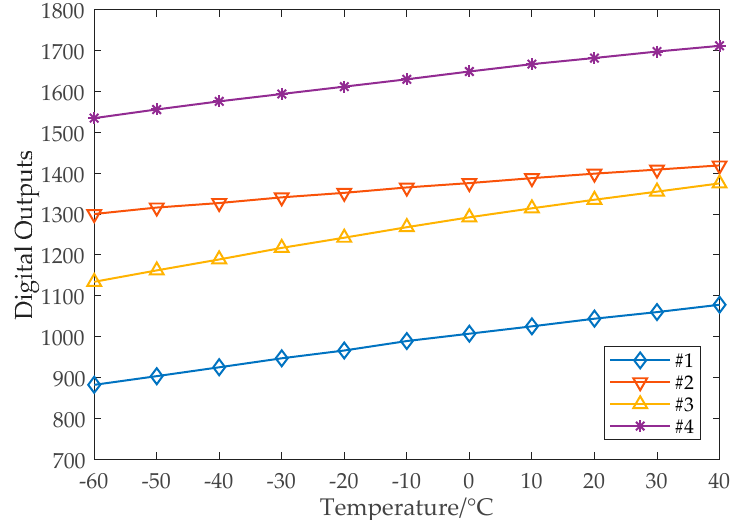
Figure 9. Measured temperature sensor outputs without calibration.